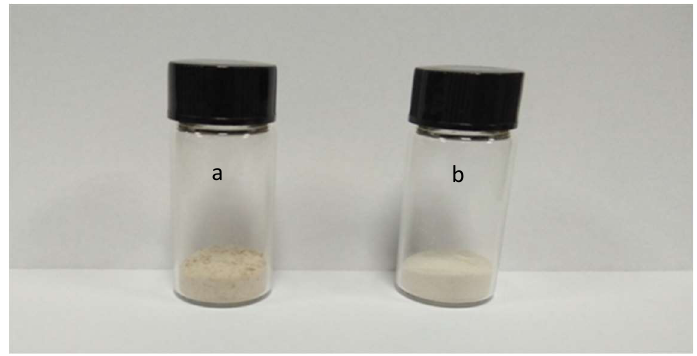
Figure 2. ( a ) Freeze-dried inulin sample and ( b ) spray-dried inulin sample.